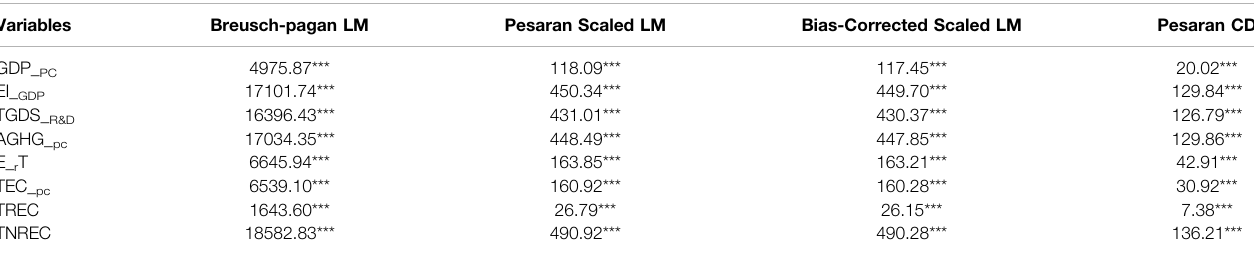
TABLE 6 | Results of the cross-sectional dependency test.